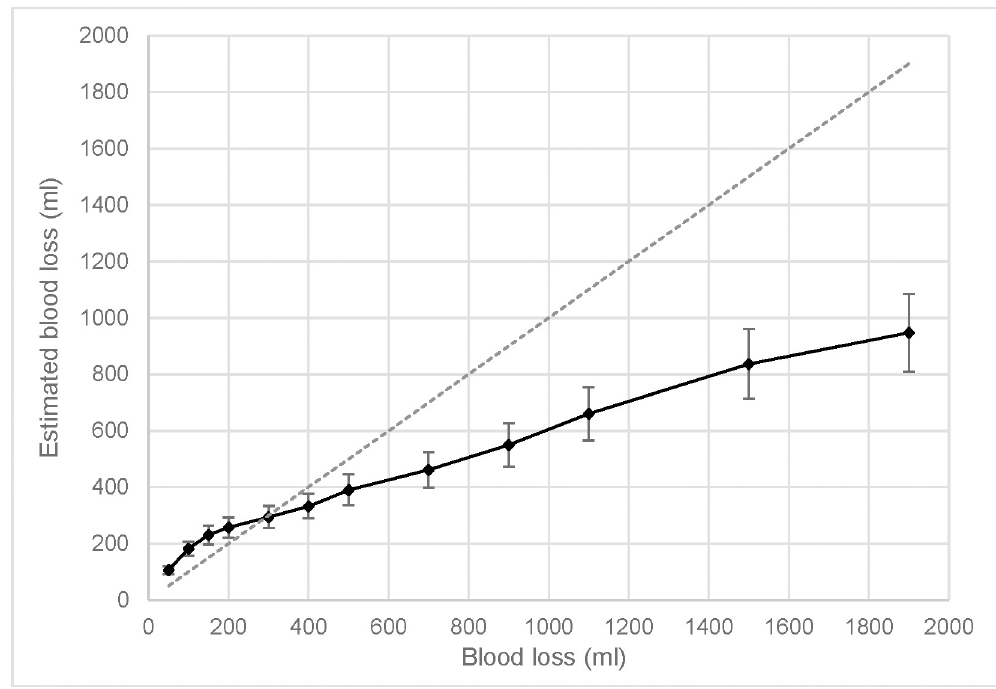
Fig 2. Estimated blood loss over actual blood loss. The black line shows mean estimates, with 95% CI as error bars. The dashed gray line indicates an accurate assessment.